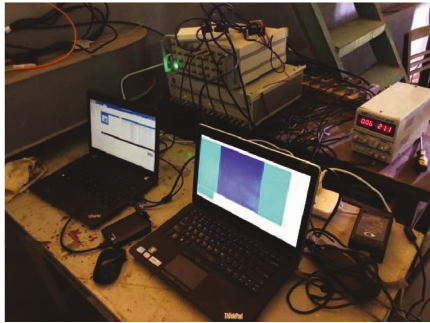
Figure 5: Acquisition